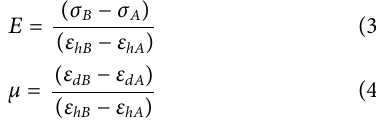
Frontiers in Materials |